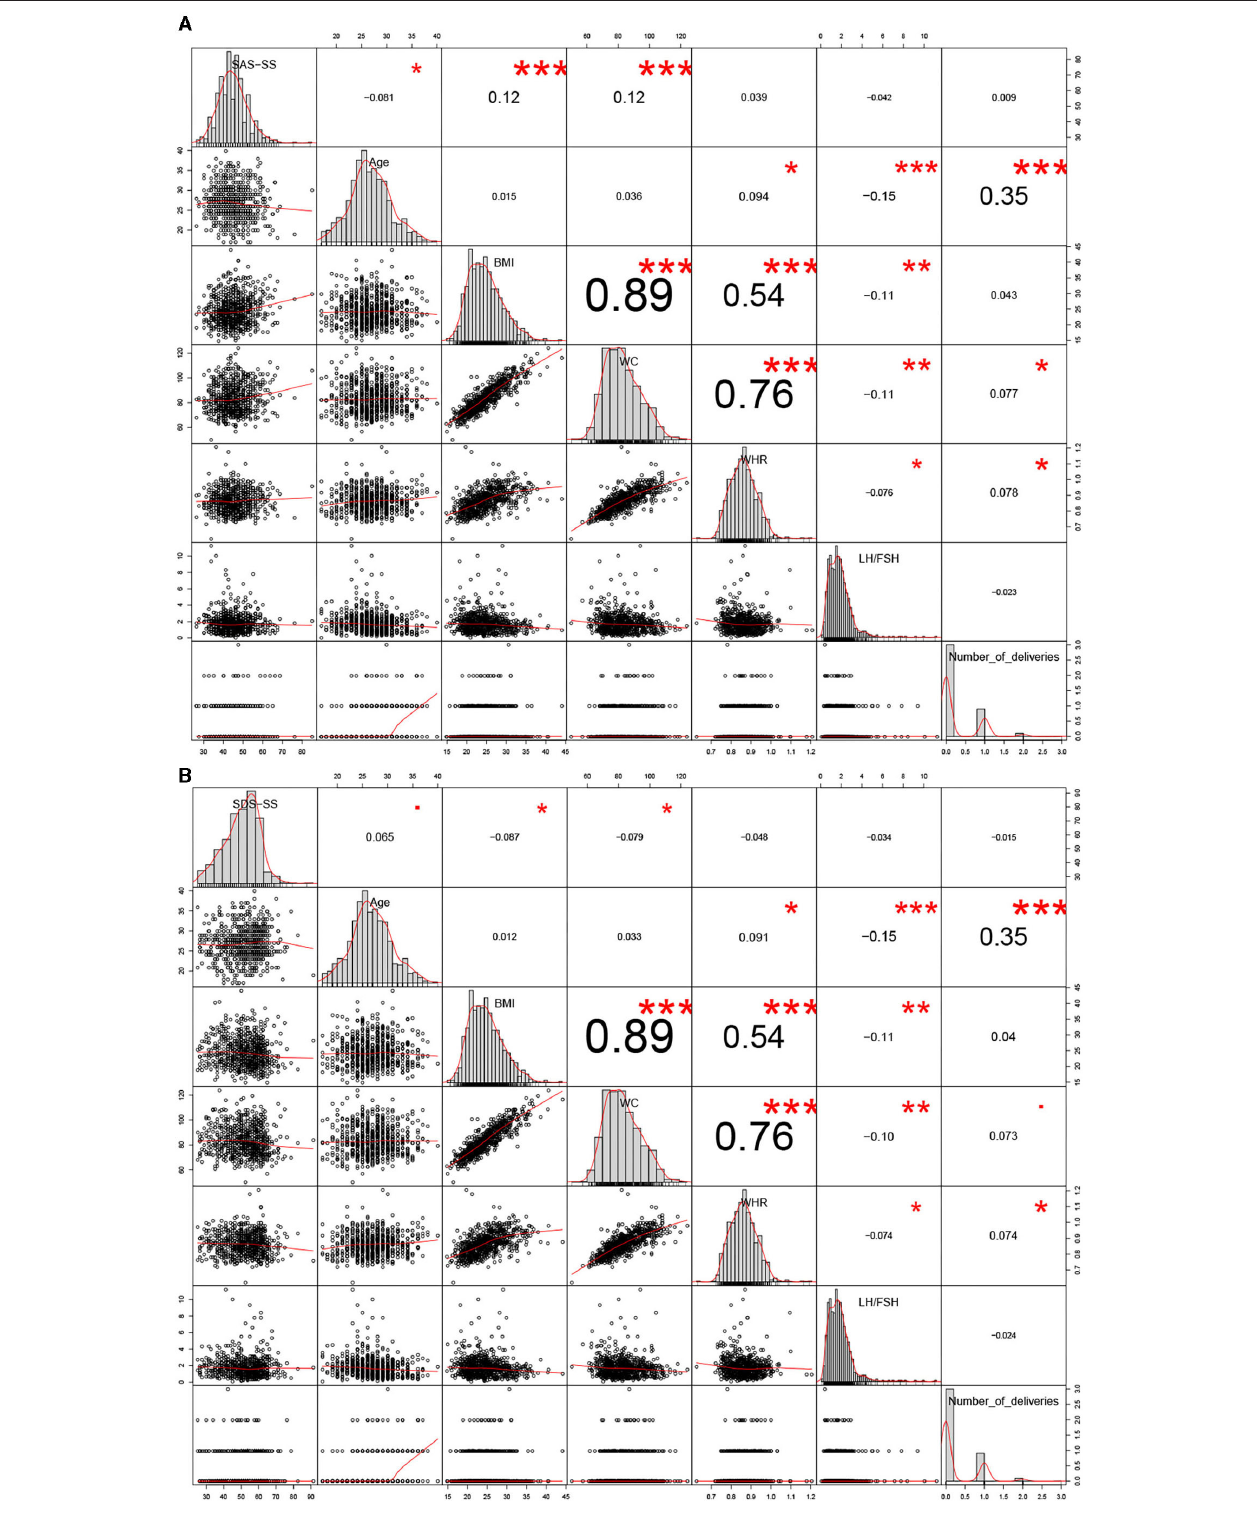
FIGURE 1 | Correlation analyses between anxiety/depression-like behaviors and the 14 clinical parameters. * P < 0.05, ** P < 0.01, *** P < 0.005.